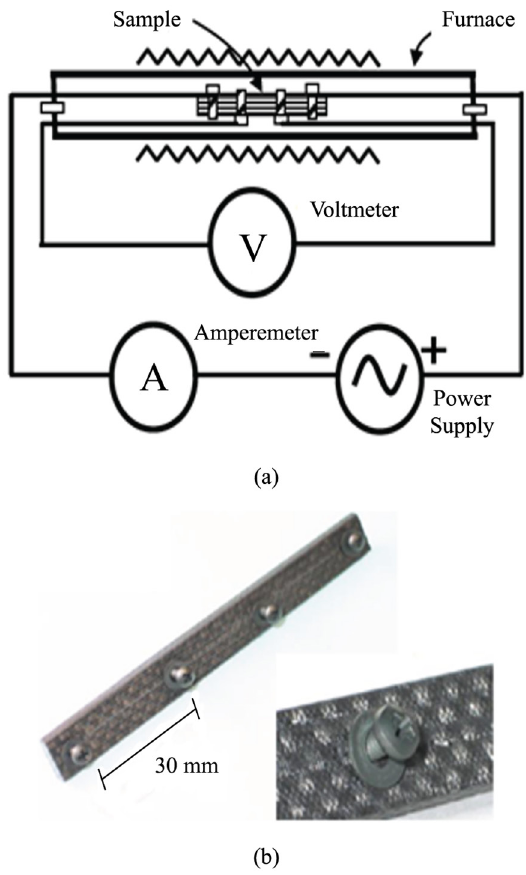
Figure 1. (a) Schematic of the set-up of electrical resistivity measurement, (b) carbon fiber/phenolic composite sample showing equidistant attached screw terminals.